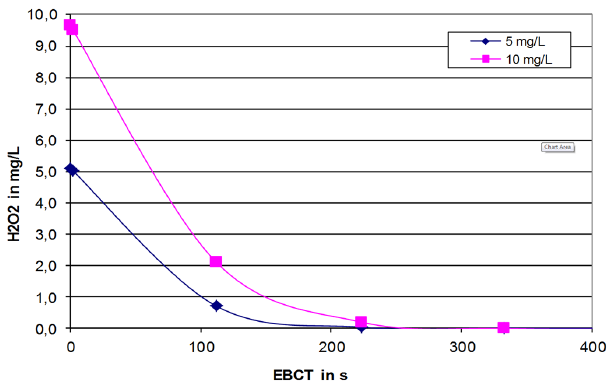
Figure 3. Decomposition over MCFgw in R40 (bed height 2.3m, flow rate 25mh − 1 , water temperature 3.3 ◦ C).